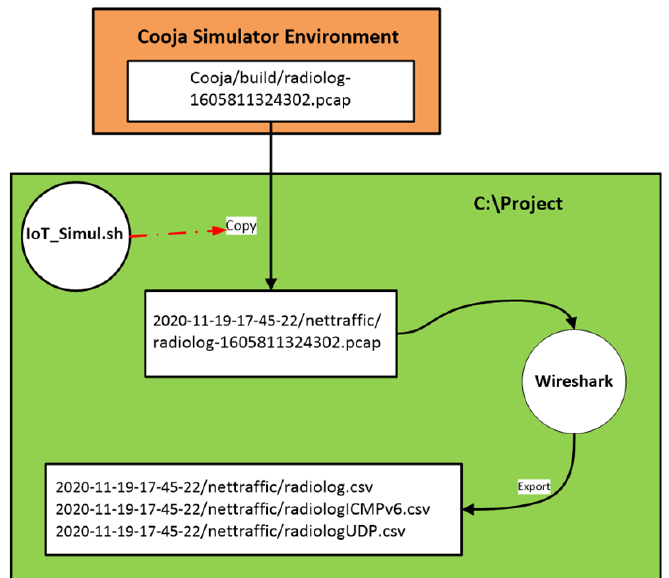
Figure 19. The “radiologICMPv6.csv” file and the “radiologUDP.csv” file in the “nettraffic” folder in the project environ- ment.